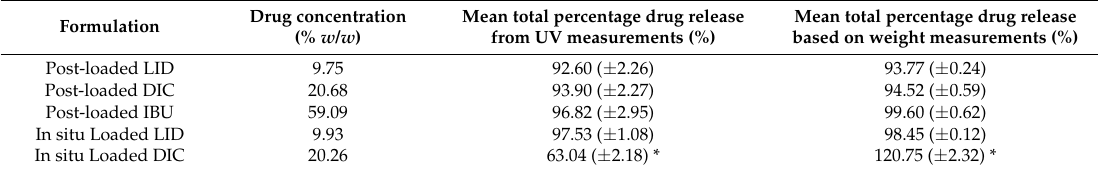
Table 8. Comparison of total percentage drug release obtained from release studies to percentage release values calculated by weight measurements. Values in brackets indicate the standard deviation from reported mean ( n = 4; * Significantly different between compared